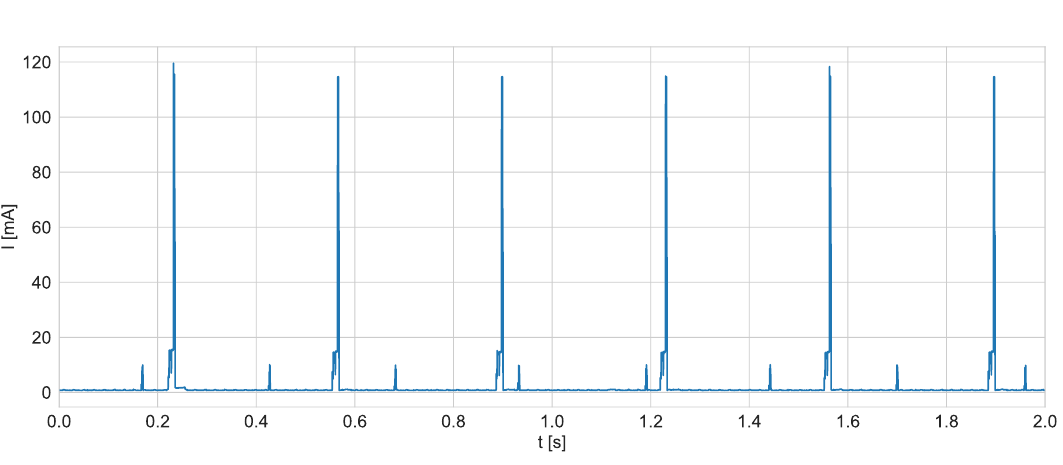
Figure 14. Current consumption during two seconds of the tag’s